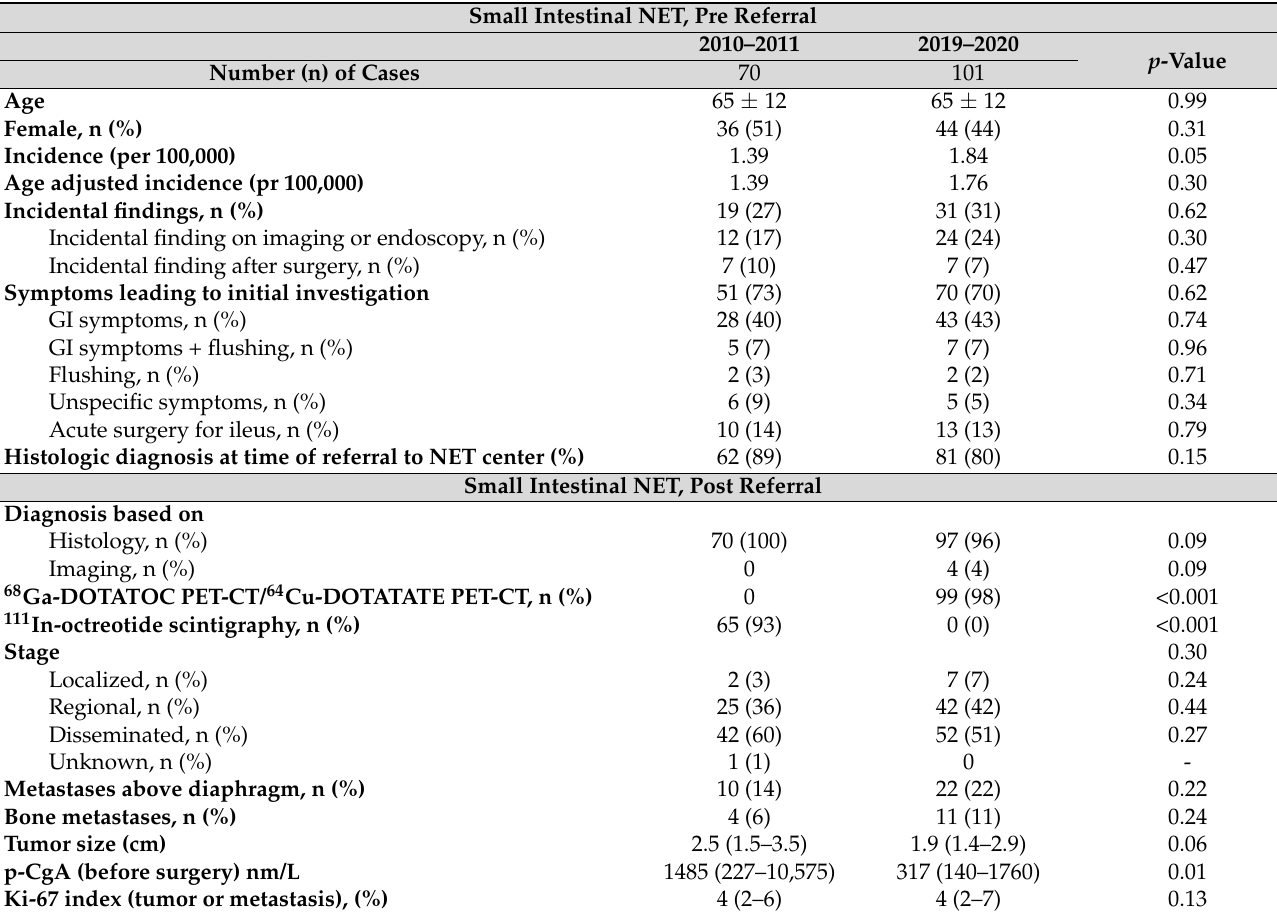
Table 1. Baseline characteristics of small intestinal NET